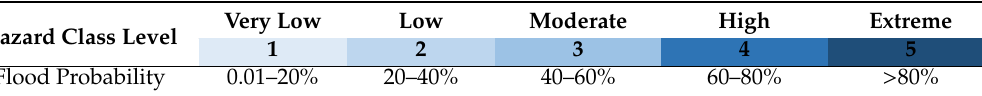
Table 4. Extreme Flood Hazard Index (EFHI) classification levels and respective conditional probability interval for an SLR scenario, relative to the respective central flooding elevation reference level (EFHI levels are related with color scale of hazard mapping, from 1—Light Blue to 5—Dark Blue).